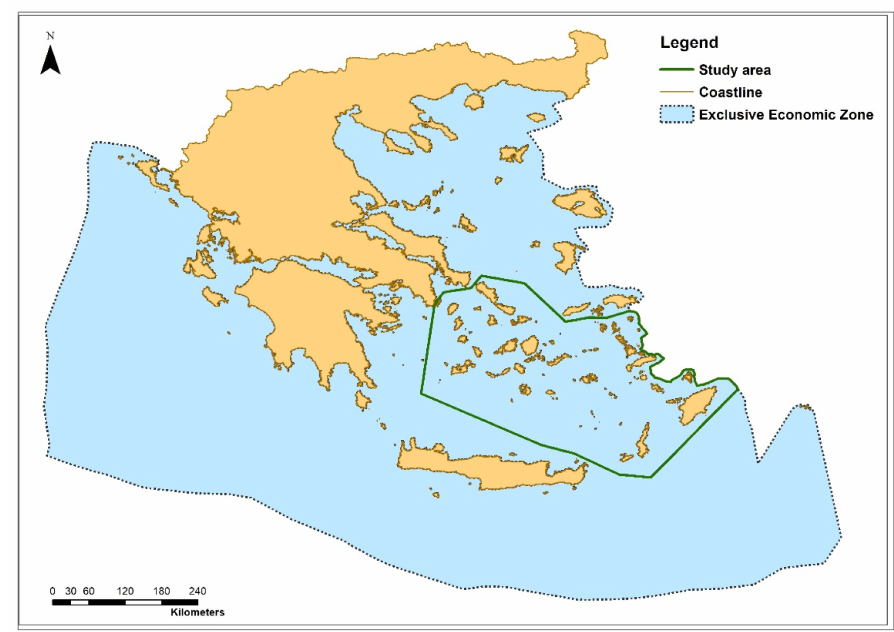
Figure 2. Definition of the study